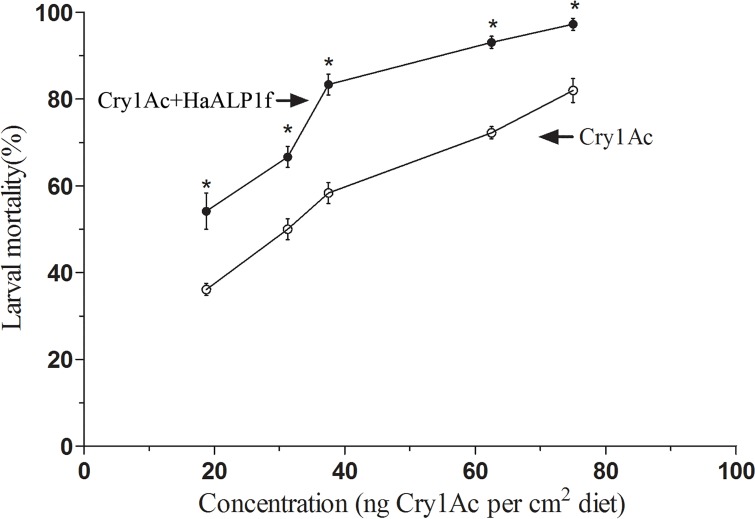
Effect of HaALP1f on toxicity of Cry1Ac activated toxin to a susceptible strain (96S) of H. armigera.The ratio of HaALP1f:Cry1Ac was 15:1 by weight. Asterisks denote significantly higher mortality with a mixture of HaALP1f and Cry1Ac than with Cry1Ac alone (P < 0.05) at a particular concentration of Cry1Ac.